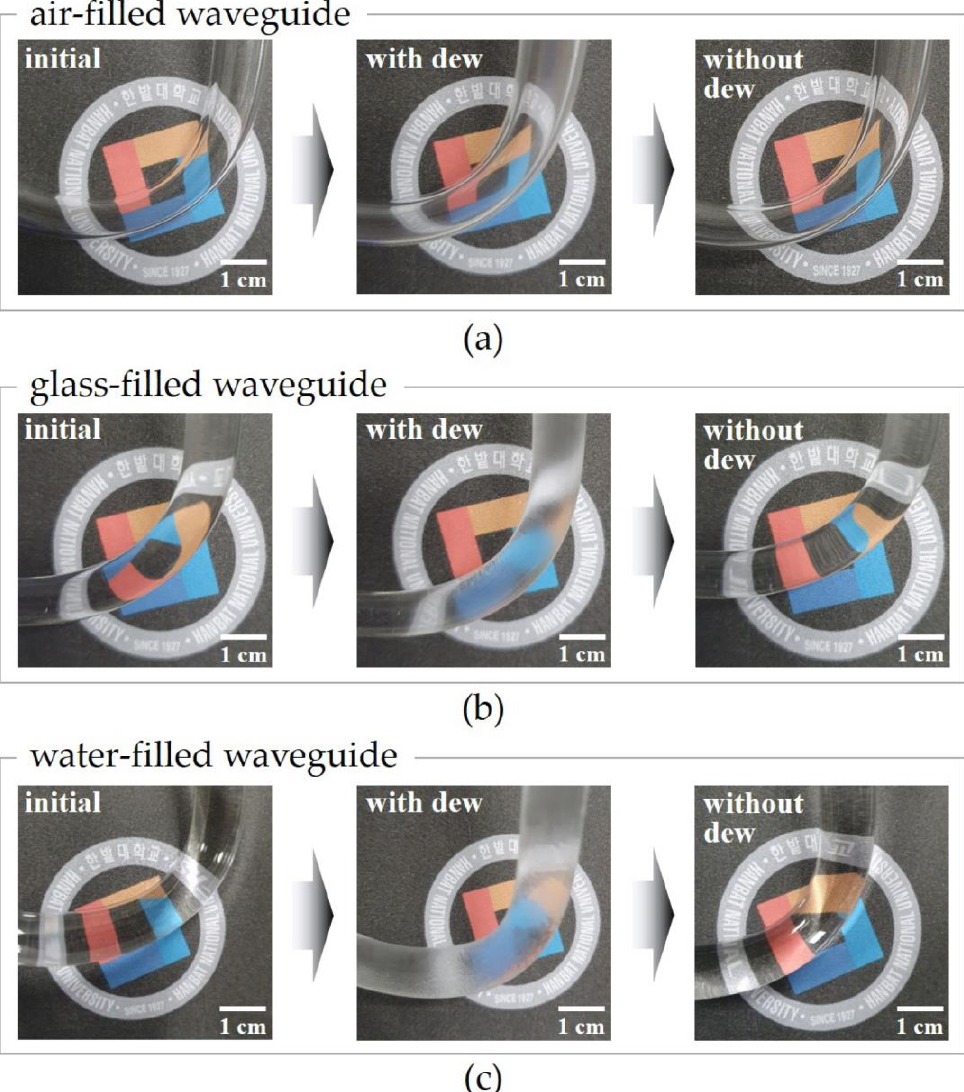
Figure 6. The photos of the ( a ) air-filled waveguide, ( b ) glass-filled waveguide, and ( c ) water-filled waveguide before the dew formation (‘initial’), after the dew formation (‘with dew’), and after the dew evaporation (‘without dew’) in sequence.